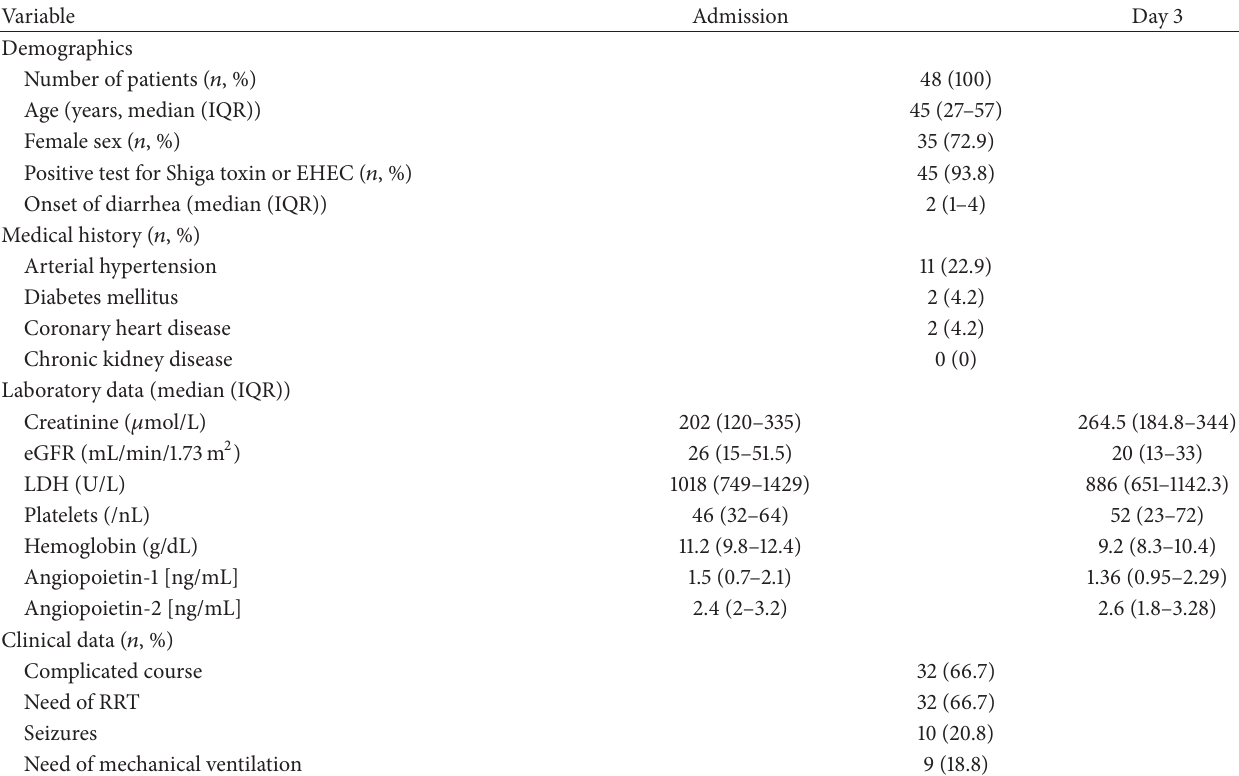
Table 1: Characteristics, chemistry values, and clinical symptoms in 48 patients with STEC-HUS mediated by Escherichia coli